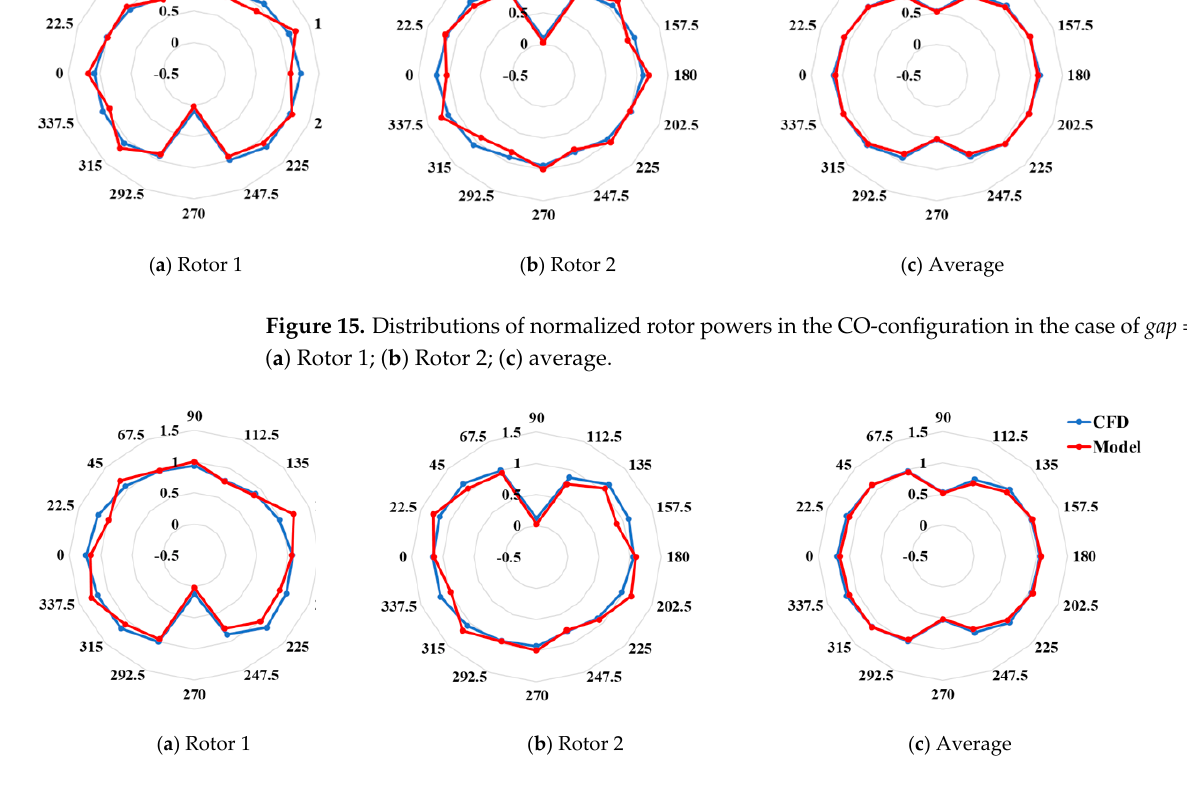
Figure 16. Distributions of normalized rotor powers in the IR − configuration in the case of gap = 2.0 D : ( a ) Rotor 1; ( b ) Rotor 2; ( c ) average.